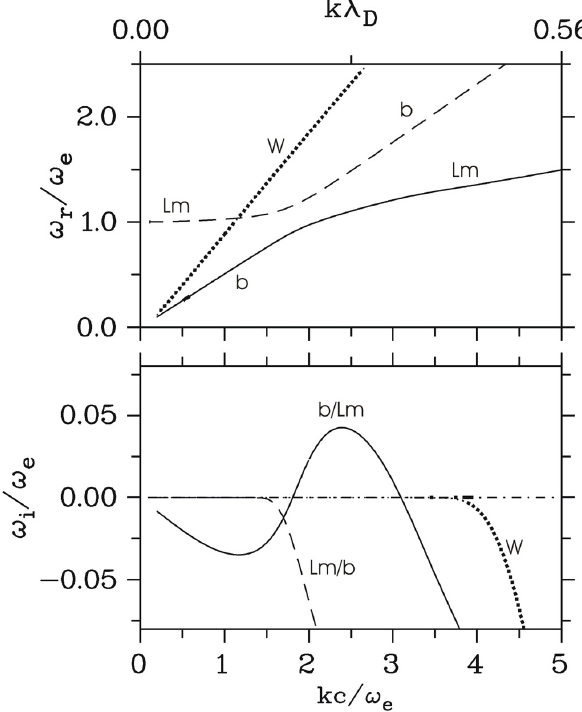
Fig. 9. Dispersion of beam-excited Langmuir waves, Vlasov ap- proach: Real (top panel) and imaginary part of frequency (bottom panel) versus wave number k (all in normalized units) as result of Vlasov dispersion theory. The parameters are: θ = 0 ◦ (parallel propagation), G = 5, β e = 0 . 001, n b / n o = 0 . 005, V b /c = 0 . 5 and T b / T e = 0 . 5. The dotted line marks the whistler mode which is nearly undamped within the considered wave number range. The scale on top gives the wave number in units of the reciprocal Debye length λ D according to kλ D = G ( kc/ω e ) ( β e /2) 1 / 2